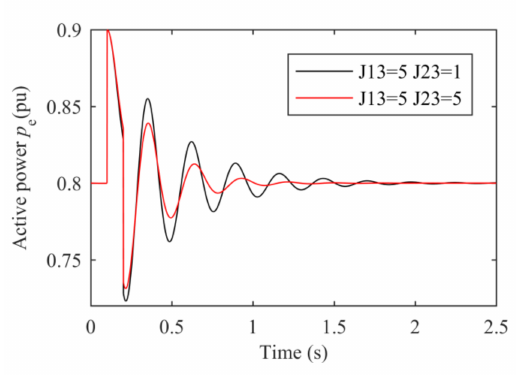
Figure 6. Effects of structure factor J 23 on the DGS.